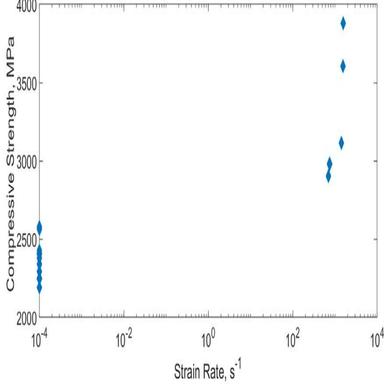
Semi-log plot of the compressive strength of the cermet with respect to the strain rates under uniaxial loading.